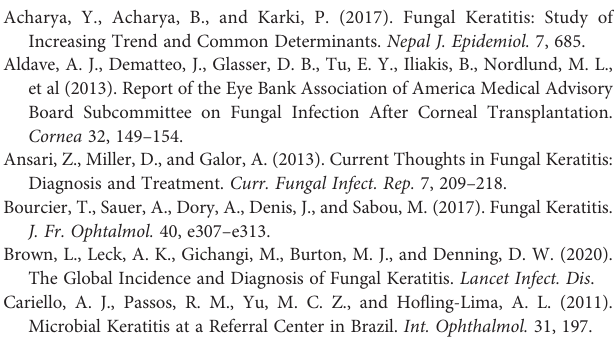
Supplementary Figure 13 | The forest plot of the prevalence of fungal keratitis among patients undergone keratoplasty based on the reported articles between